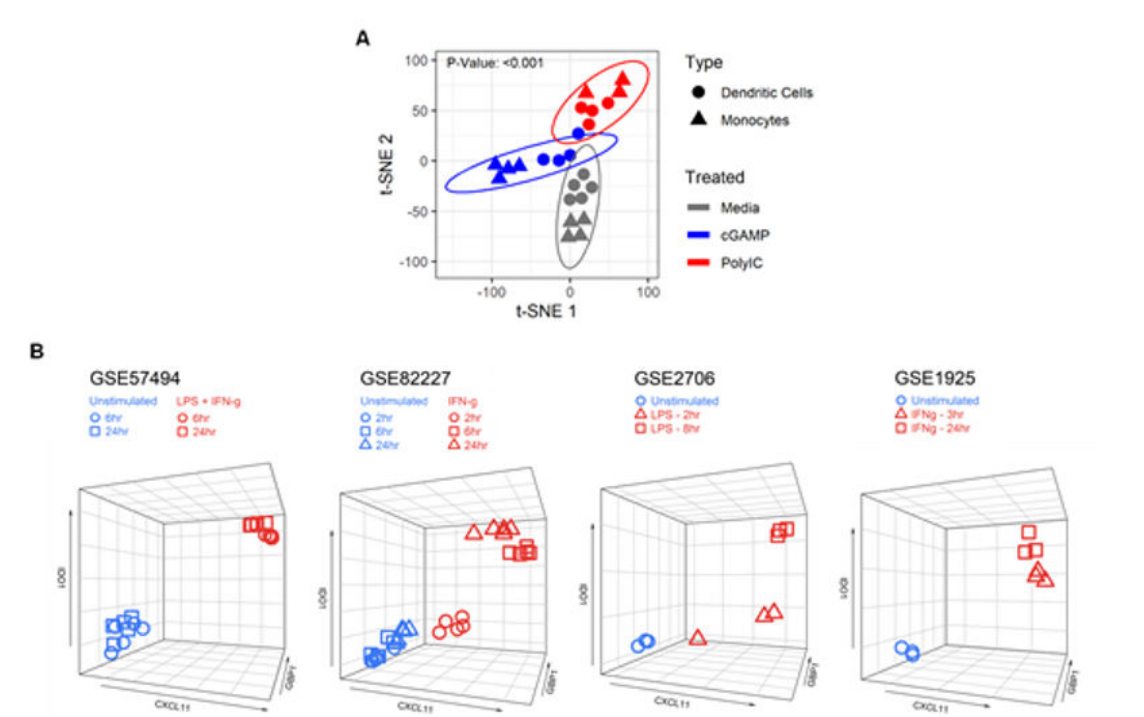
Figure 1. Identification of a three gene signature characteristic to activated myeloid cells. ( A ) Dendritic cells (DC) and CD14 + monocytes were isolated from healthy donors and stimulated with poly(I:C) (10 µ g / mL) or cGAMP (10 µ g / mL) for 6 h in vitro. Gene expression counts were quantified using the NanoString nCounter Immunology Panel. Unsupervised t-Distributed Stochastic Neighbor Embedding (t-SNE) analysis showed significant clustering between unstimulated and stimulated cells for both monocytes and DC. ( B ) IDO1, CXCL11, and GBP1 expression values (RNA-seq, microarray) of unstimulated and stimulated myeloid cells using public Gene Expression Omnibus (GEO) datasets: GSE57494 (LPS + IFN γ ), GSE82227 (IFN γ ), GSE2706 (LPS), and GSE1925 (IFN γ ) plotted as 3D scatter plots using the R package plotly and show clustering between unstimulated and stimulated cells. Table 1. Signed fold-change table of common genes that were di ff erentially expressed upon cGAMP or poly(I:C) stimulation in both monocytes and dendritic cells.